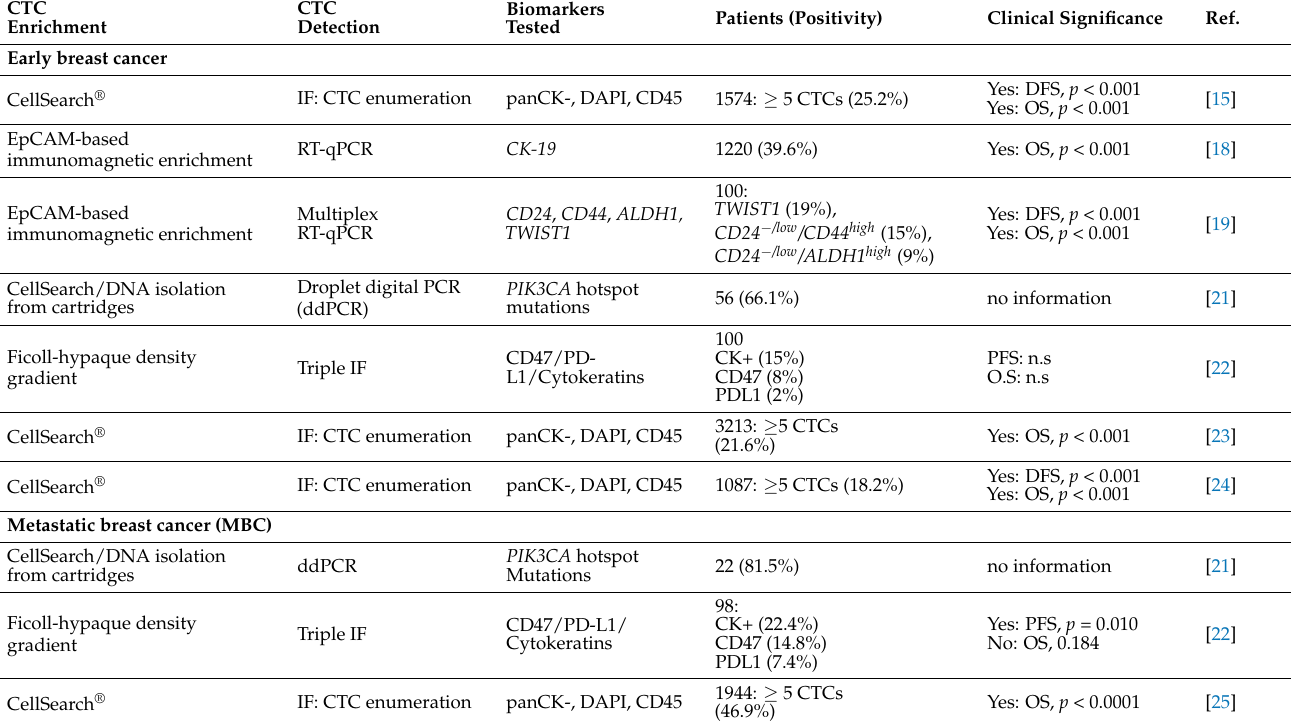
Table 1. Overview of clinical studies in CTCs on breast cancer